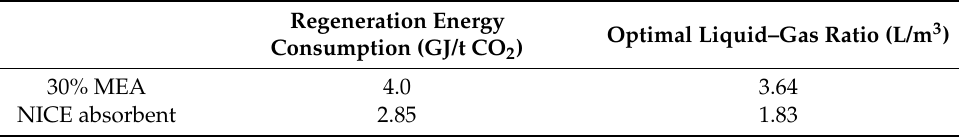
Table 1. Comparing the regeneration energy consumptions and the optimal liquid–gas ratios of the NICE absorbent and